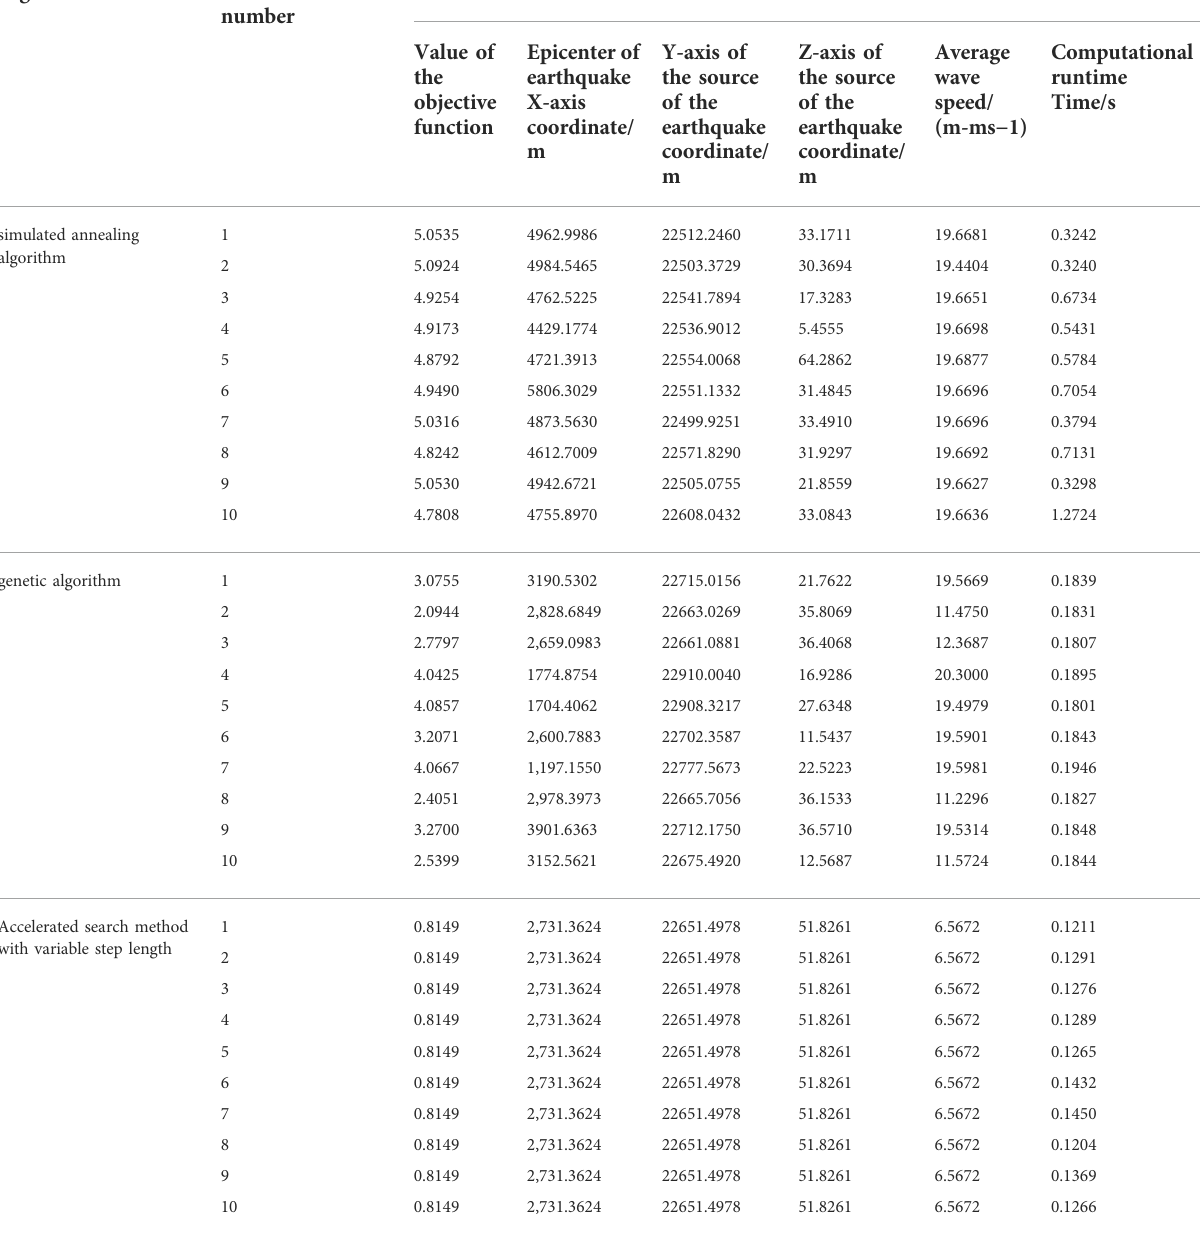
TABLE 5 The location results of the three